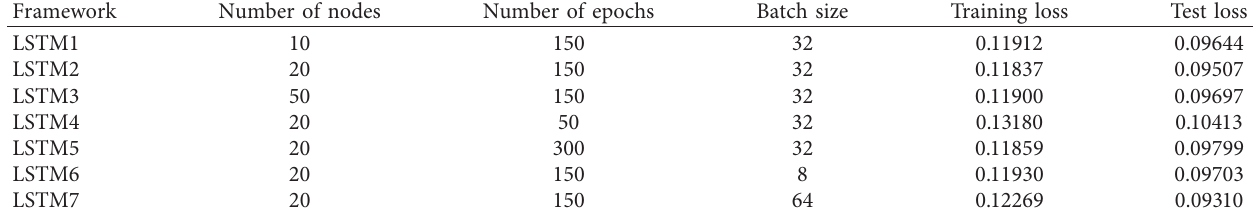
Table 3: Training loss and test loss of LSTM frameworks with different